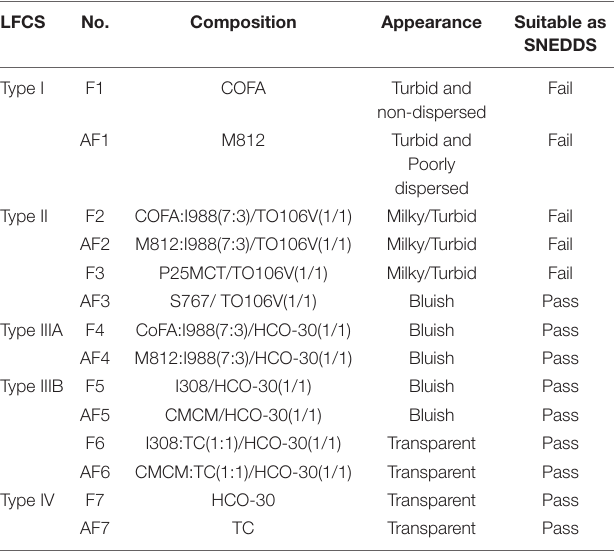
TABLE 1 | The assessment of various formulations within lipid formulation classification systems (LFCSs) under specific self-emulsification condition